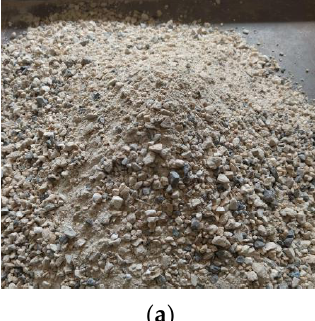
Figure 1. Consumable materials of the research include ( a ) aggregate materials of the base layer, ( b ) zeolite, and ( c ) cement.